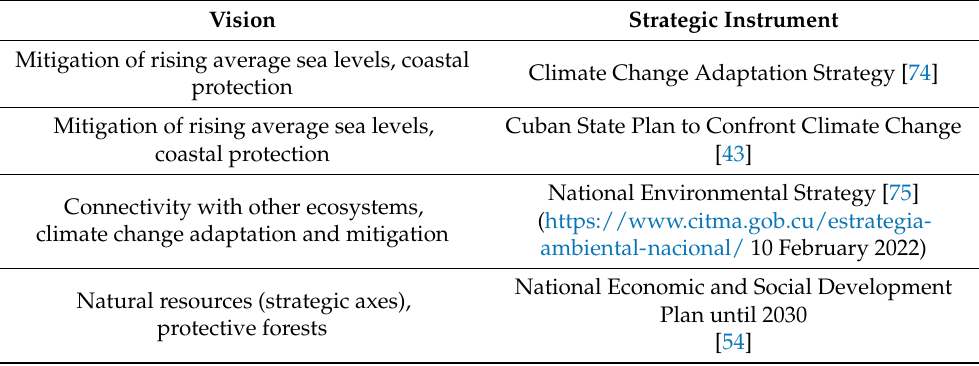
Table 5. Strategic instruments in Cuba include activities in mangroves and the vision of the ecosystem within